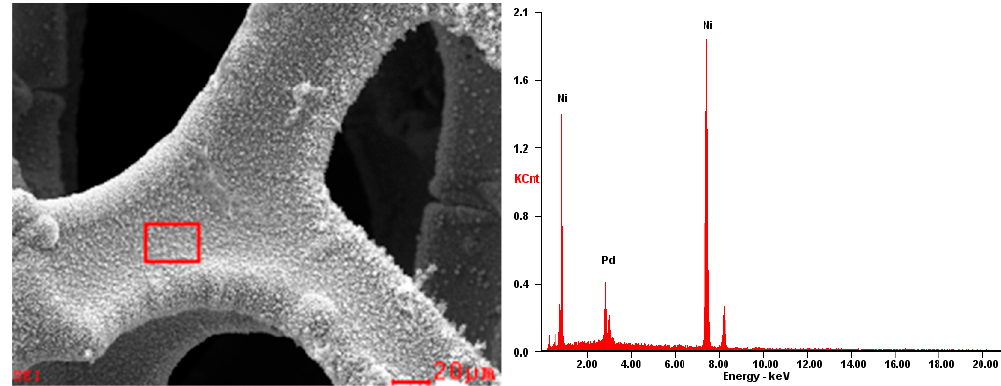
Figure 2. EDX elemental analysis of Pd/Ni electrode.